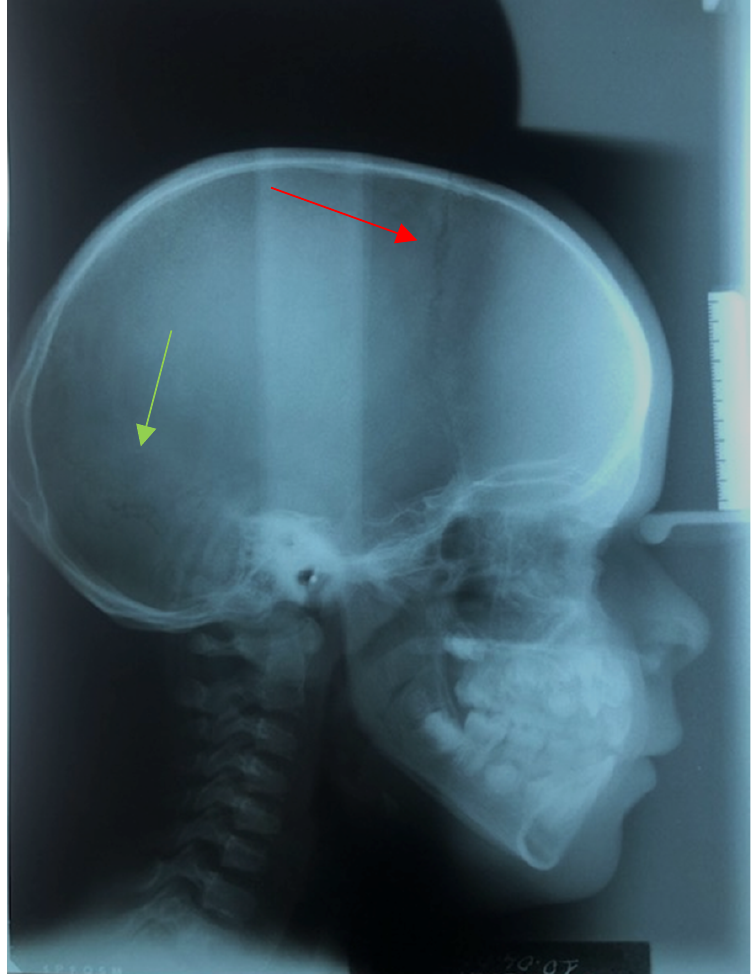
Figure 2. Initial 10/04/2008 teleradiography X-ray sagittal plane (10-year-old): evidence of delayed closure of cranial suture (arrows).